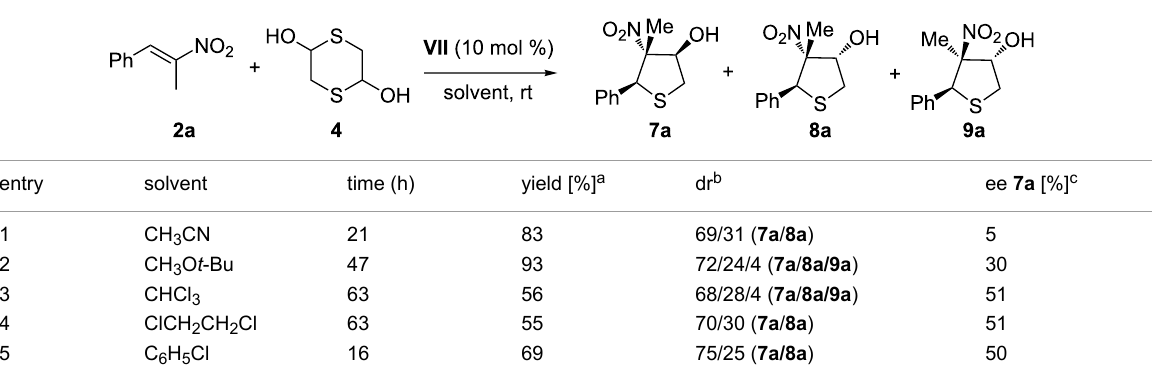
Table 2: Solvent screening in the asymmetric Michael/nitroaldol reaction of 2a with 1,4-dithiane-2,5-diol ( 4 ) catalysed by amine thiourea VII .